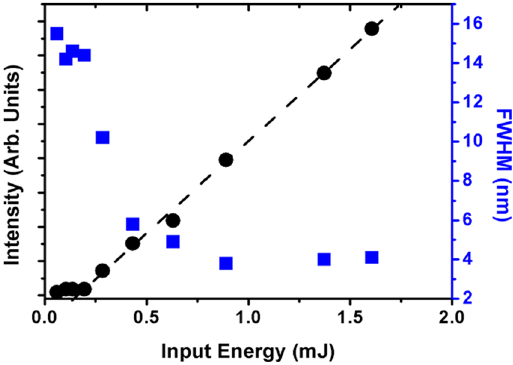
Figure 7. Emitted intensity (black circles) and emission bandwidth (blue squares) in the CA-ZnO-Ag RL – a clear reduction of the RL threshold due to the presence of the Ag NPs can be observed (compare with Fig.